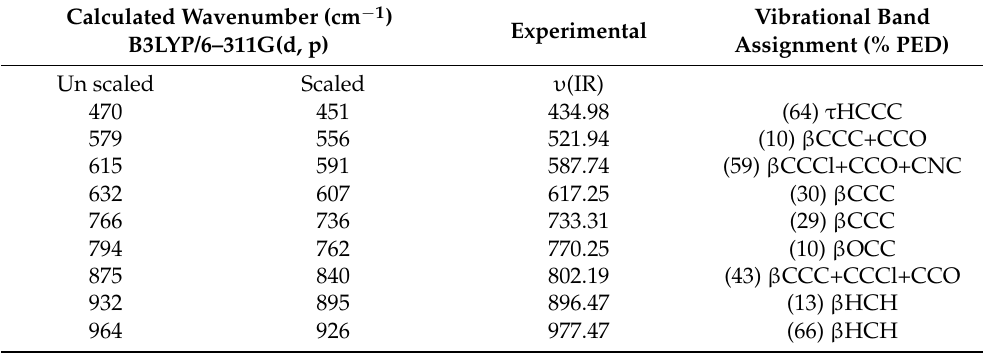
Table 2. The calculated and experimental wavenumber (cm − 1 ) B3LYP/6–311G(d, p) of compound 2